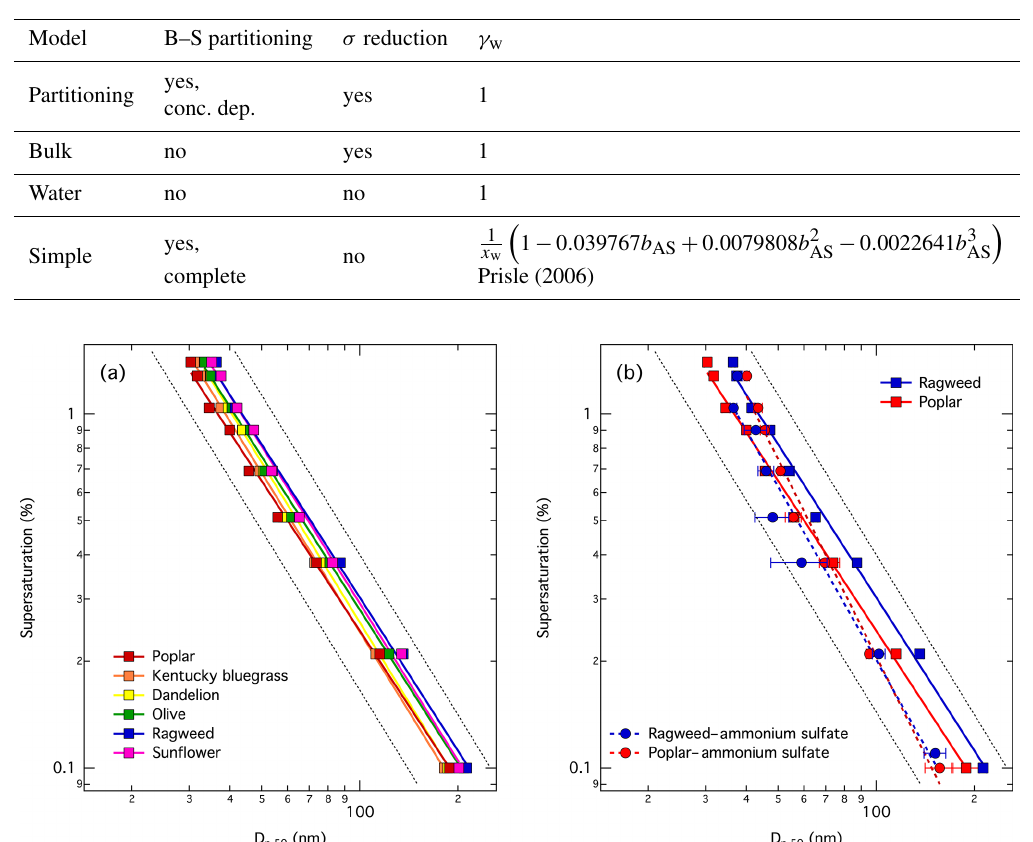
Table 1. Main assumptions regarding surface tension ( σ ), bulk-to-surface (B–S) partitioning, and water activity in terms of the mole-fraction- based water activity ( a w = γ w x w ) coefficient, γ w , in the four Köhler models used. In the water activity parametrization of Prisle (2006), b AS is the molal concentration of binary AS in the droplet bulk.